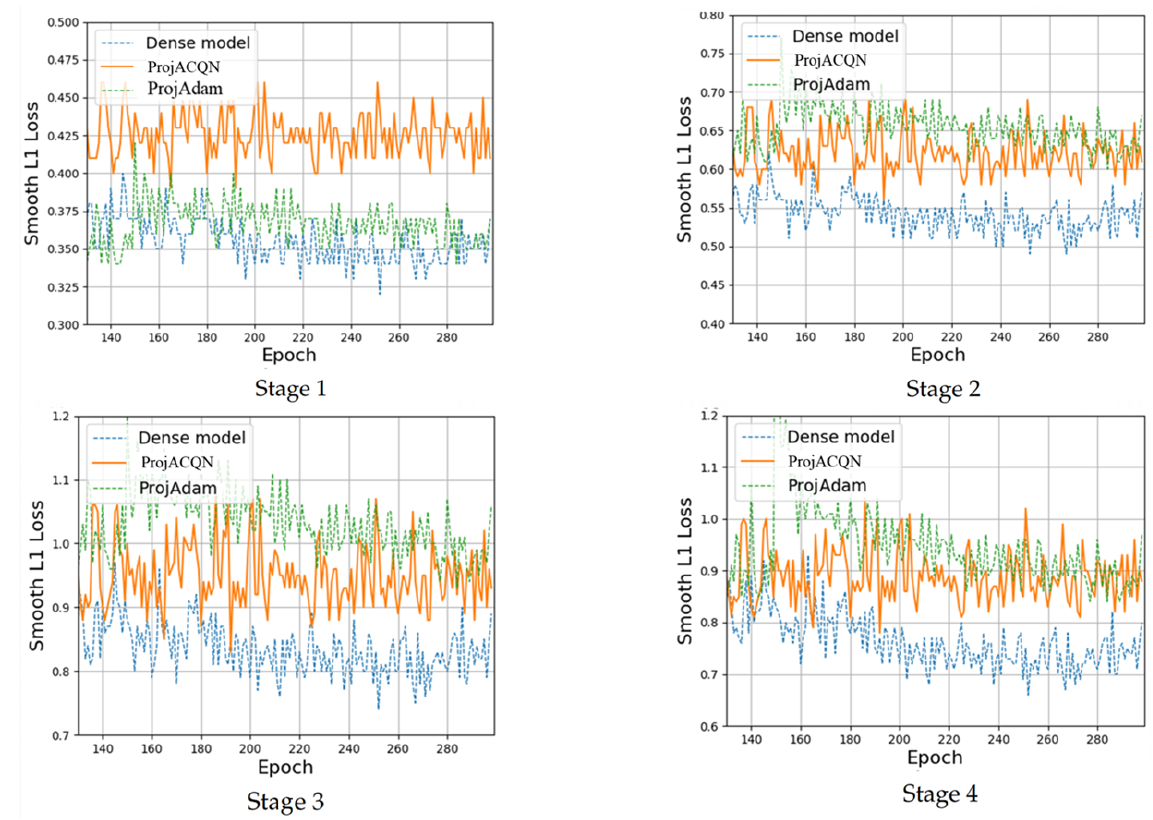
Figure 1. The training loss curves of four stages on KITTI-2012 under 70% energy